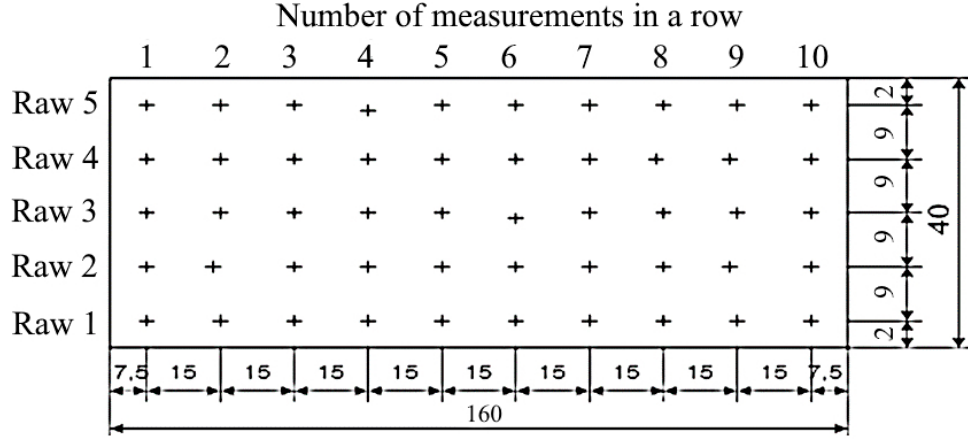
Figure 1. Scheme for measuring the surface roughness of paint coatings on a cement substrate (all dimensions are given in mm).